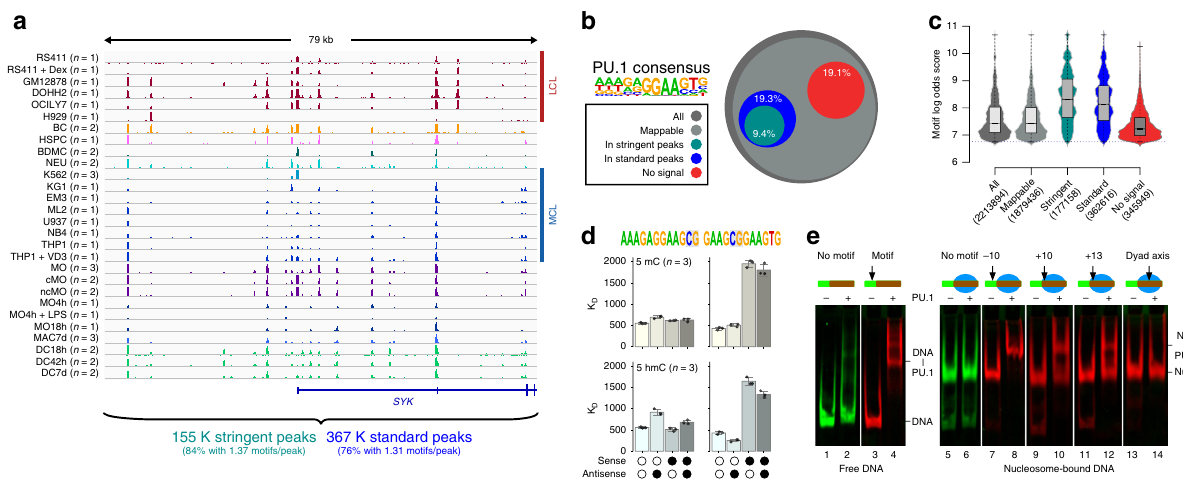
Fig. 1 PU.1 occupancy in vivo and binding constraints in vitro. a Comparison of PU.1 ChIP-seq data across various human lymphoid and myeloid cell lines (LCL and MCL, respectively) and primary cells (BC B cells, BDMC breast skin-derived mast cells, cMO classical MO, DC dendritic cells, HSPC hematopoietic stem and progenitor cells, MAC, macrophages, MO monocytes, ncMO non-classical MO, NEU neutrophils) at an exemplary locus. For replicated data sets (as indicated), averaged coverage tracks are shown. Total motif occurrences in standard and stringent peaks are summarized below the tracks. b Fraction of PU.1 motifs residing in either standard or stringent PU.1 peaks (3.61 × 10 5 and 1.77 × 10 5 , respectively) compared with all motif occurrences (2.21 × 10 6 ) across the genome, motifs fi ltered for mappability (1.88 × 10 6 ), as well as motifs that showed no evidence of binding (<3 per 10 7 reads within 200 bp motif-centered window) across all samples (no signal, 3.48 × 10 5 ). c Distribution of motif scores across total occurrences, mappability- fi ltered motifs, motifs in peaks, and no-signal motifs. d Microscale thermophoresis-derived dissociation constants ( K D values, bars represent the mean of n = 3 experiments ± SD, individual data points are shown as black dots) for the interaction between recombinant full-length PU.1 and the indicated double-stranded oligonucleotides representing PU.1 motifs with a high motif log odds score (left panels, 9.4; right panel 8.8). Open circles indicate unmethylated cytosines. Black circles represent methylated or hydroxymethylated cytosines (top panels, 5mC or bottom panels, 5hmC, respectively). e Gelshift assays demonstrating position-dependent binding of PU.1 to nucleosome-associated DNA. The relative position of the PU.1-binding site (arrow) to the nucleosome boundary is indicated. Nucleosomes are positioned by the 601 nucleosome-positioning sequence marked in red. The positions of free DNA (DNA) and nucleosomes (nuc), as well as of DNA-PU.1 and nuc-PU.1 complexes are indicated. a – d Source data are provided as a Source Data fi